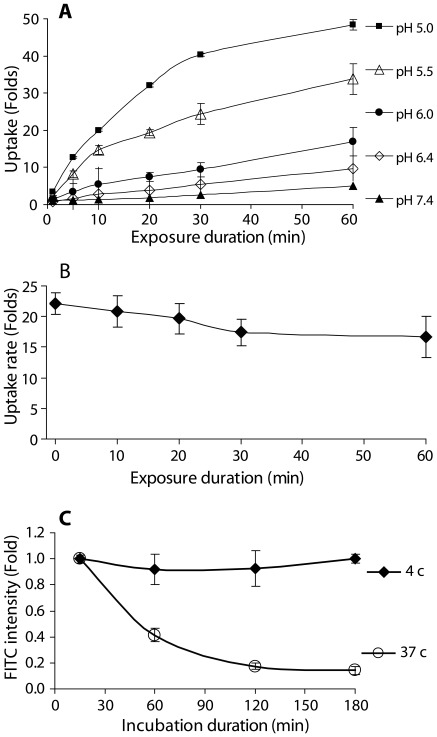
Kinetic profile of PIU.(A) The relative intensities of dextran-FITC (70 kD, 10 µM) in HaCaT cells are presented as function of external pH and duration of exposure. Suspensions of cells were exposed to solutions of varying pH (7.4, 6.4, 6, 5.5 and 5) in the presence of dextran-FITC for 6 time periods (1, 5, 10, 20, 30 and 60 min). Results from FACS analyses are presented as fold induction relative to the constitutive uptake at physiological pH 7.4, in terms of geometrical mean±SD (n = 15 per each pH level). (B) The rate of dextran PIU is presented as function of the time the cells were exposed to low pH. Rate was determined by introducing Dextran-FITC as a short pulse for the last 10 min of the cells’ exposure to pH 5.25. Results from FACS analyses are presented as fold induction relative to the constitutive uptake at physiological pH 7.4, in terms of geometrical mean±SD (n = 9). (C) The relative attenuation of the intracellular intensity of dextran-FITC, as function of incubation time and temperature. The cells were initially loaded with Dextran-FITC by mean of PIU. The time dependent exponential decrease in cellular fluorescence suggests the involvement of efflux mechanisms which are concentration dependent, while the dependence on temperature suggests the efflux to be a methabolic driven process. Cell suspensions were pre-loaded with dextran-FITC (70 kD, 10 µM) by exposure to extracellular pH 5.25 for 10 min. The cultures were then washed in fresh HBSS and divided into two groups, incubated at either 37°C or 4°C for four time periods (15, 60, 120 and 180 min). Results from FACS analysis are presented as fold induction relative to the fluorescent intensity of cells that were analyzed 15 min after extracellular solution was restored to pH 7.4, in terms of geometrical mean±SD (n = 9 in 3 independent experiments).